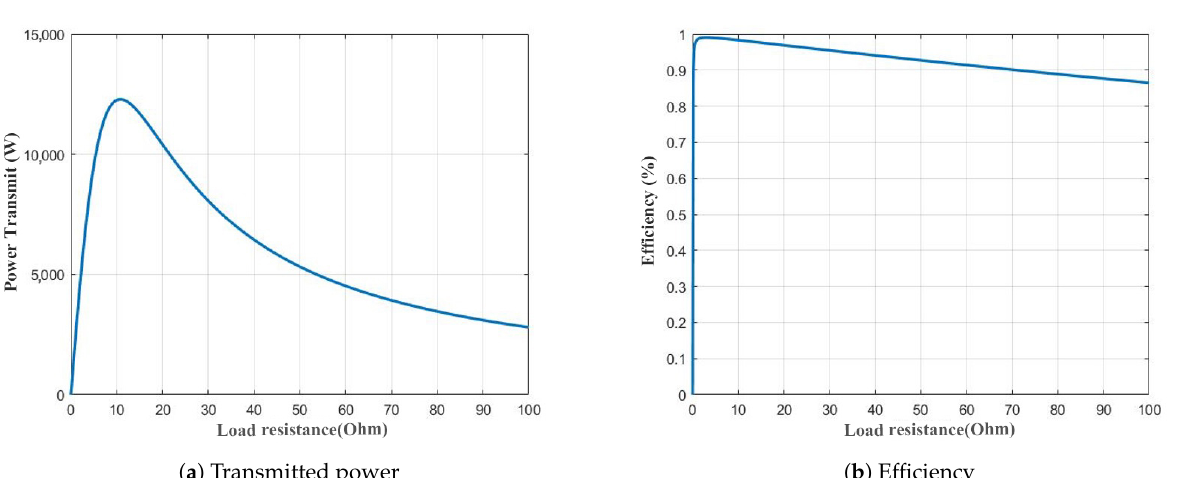
Figure 13. The effects of various load resistances.